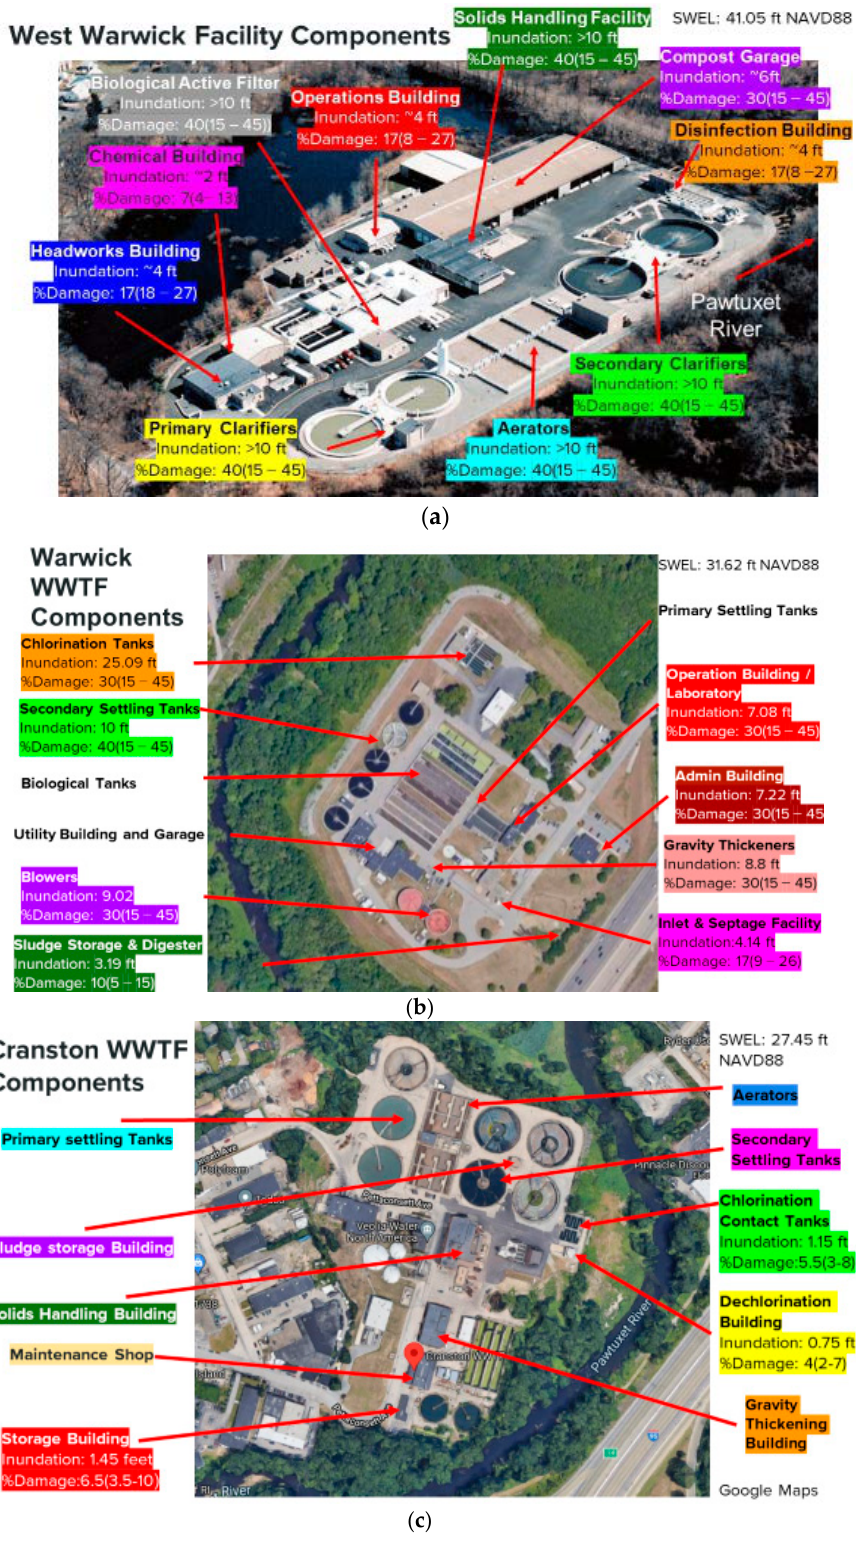
Figure 9. Aerial photographs showing the inundation and damage to each component of the West Warwick ( a ), Warwick ( b ), and Cranston ( c ) WWTF. Inundation values are measured relative to CFEs for each component of the facility and damages for average (below and above average) are provided.